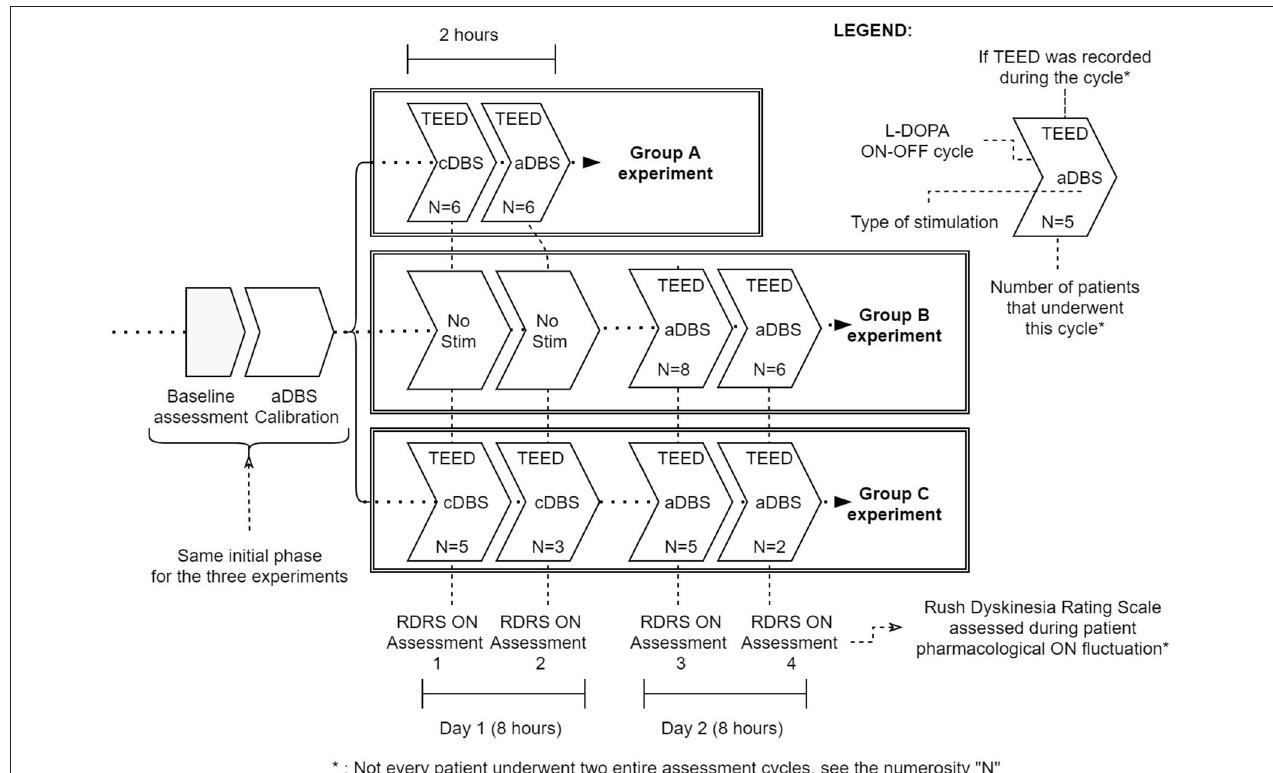
FIGURE 1 | Summary of the three experimental protocols (Group A, Group B, and Group C). Baseline assessment [including Unified Parkinson’s Disease Rating Scale part III and Rush Dyskinesia Rating Scale (RDRS) evaluation] and aDBS calibration are common to all protocols. Then, Group A underwent a 2-h cDBS or aDBS exposure (randomized) with a full levodopa cycle per day. Group B and C were studied for two levodopa cycles per day (8h study). In Group B patients during day 1 received only levodopa while in day 2 received aDBS; in Group C patients received cDBS in day 1 and aDBS in day 2 (not randomized). In each levodopa cycle we considered TEED and RDRS in Med ON - Stim ON. N represents the number of subjects assessed in each